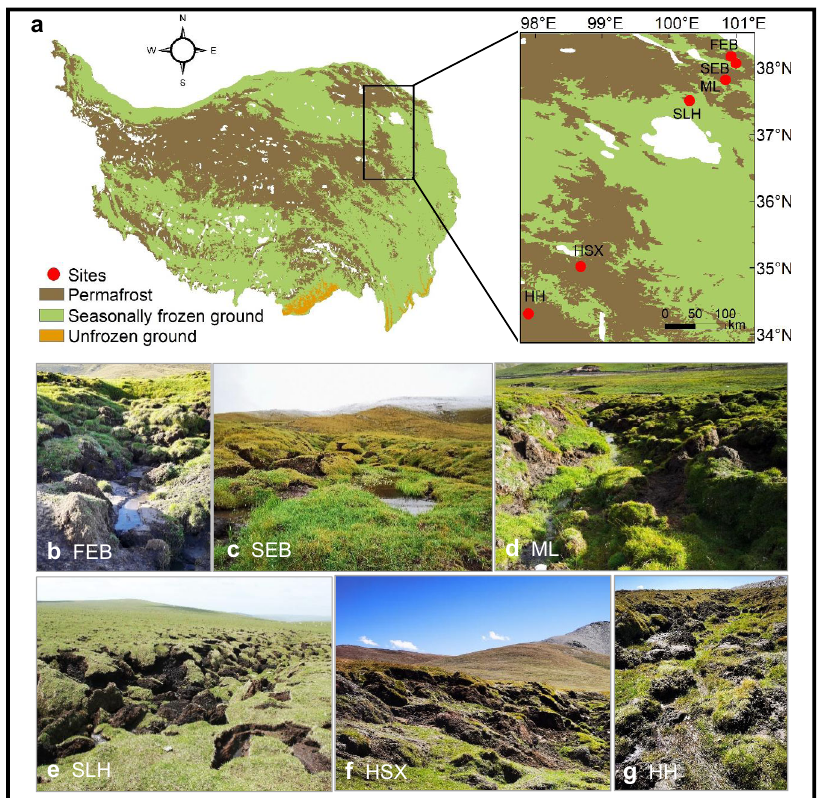
Fig. 1 | Sampling sites and landscapes of upland thermokarst on the Tibetan Plateau. a – g Sampling location of the six sites shown on the map of permafrost distribution on the Tibetan Plateau 64 ( a ) and individual features of thermokarst- impacted sites such as FEB ( b ), SEB ( c ), ML ( d ), SLH ( e ), HSX ( f ), and HH ( g ) (photo credit for panels b – g : F.T. Liu). Notably, the sites involved in this study were mainly distributed across the eastern plateau sinceupland thermokarst primarily occurred